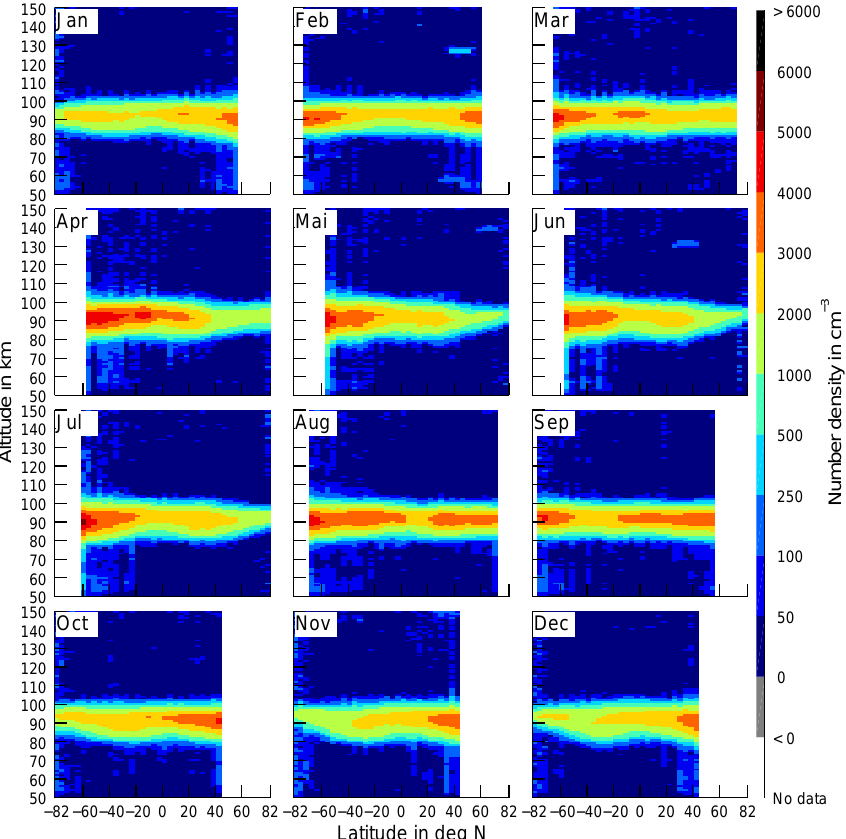
Figure 13. Latitude–altitude distribution of the monthly mean Na densities. The average of the results for both Na lines is used. Note that the highest covered latitude is at 82 ◦ N/S.